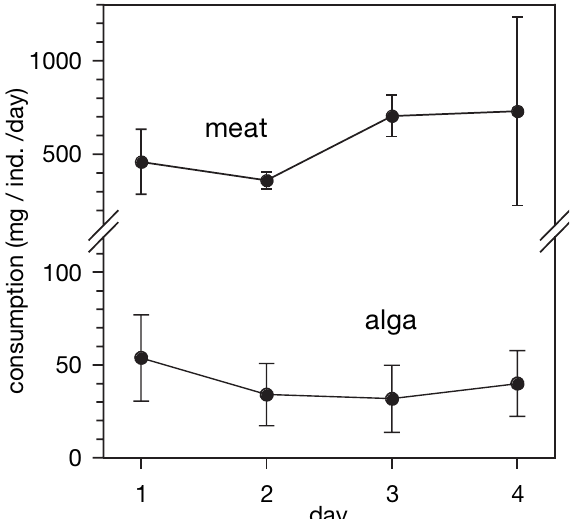
F IG . 1. – Daily average consumption rates of Munida subrugosa (n = 5) in a choice experiment between crab meat and the red alga Polysiphonia sp. during the experimental period of 5 days. Vertical lines are standard